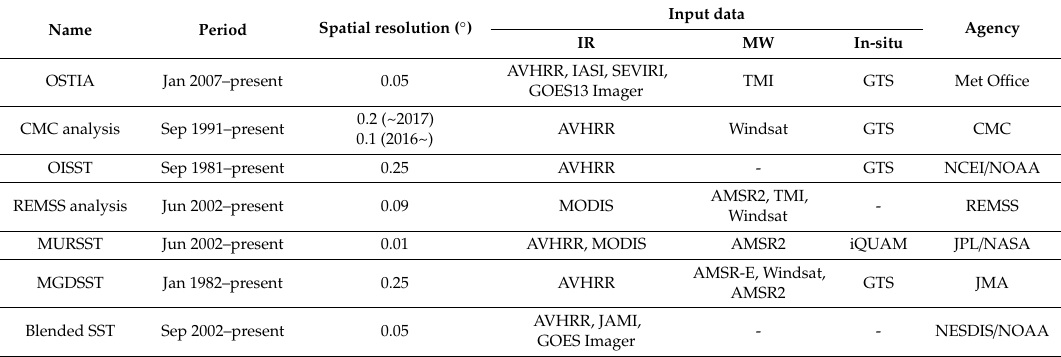
Information on the sea surface temperature (SST) analyses used in this study, where the input data were investigated based on the SST analysis information on 1 January 2014, or on information from the respective database website. Acronyms: OSTIA = Operational SST and Sea Ice Analysis, CMC = Canadian Meteorological Centre, OISST = Optimum Interpolation SST, REMSS = Remote Sensing System, MURSST = Multi-scale Ultra-high Resolution SST, MGDSST = Merged Satellite and In situ Data Global Daily SST, AVHRR = Advanced Very-High-Resolution Radiometer, IASI = Infrared Atmospheric Sounding Interferometer, SEVIRI = Spinning Enhanced Visible and InfraRed Imager, GOES = Geostationary Operational Environmental Satellite, MODIS = Moderate Resolution Imaging Spectroradiometer, JAMI = Japanese Advanced Meteorological Imager, TMI = Tropical Rainfall Measuring Mission (TRMM) Microwave Imager, AMSR2 = Advanced Microwave Scanning Radiometer 2, AMSR-E = AMSR-Earth Observing System, GTS = Global Telecommunications System, iQUAM = In situ SST Quality Monitor, Met O ffi ce = Meteorological O ffi ce, NECI = National Centers for Environmental Information, NOAA = National Oceanic and Atmospheric Administration, JPL = Jet Propulsion Laboratory, NASA = National Aeronautics and Space Administration, JMA = Japan Meteorological Agency, and NESDIS = National Environmental Satellite, Data, and Information